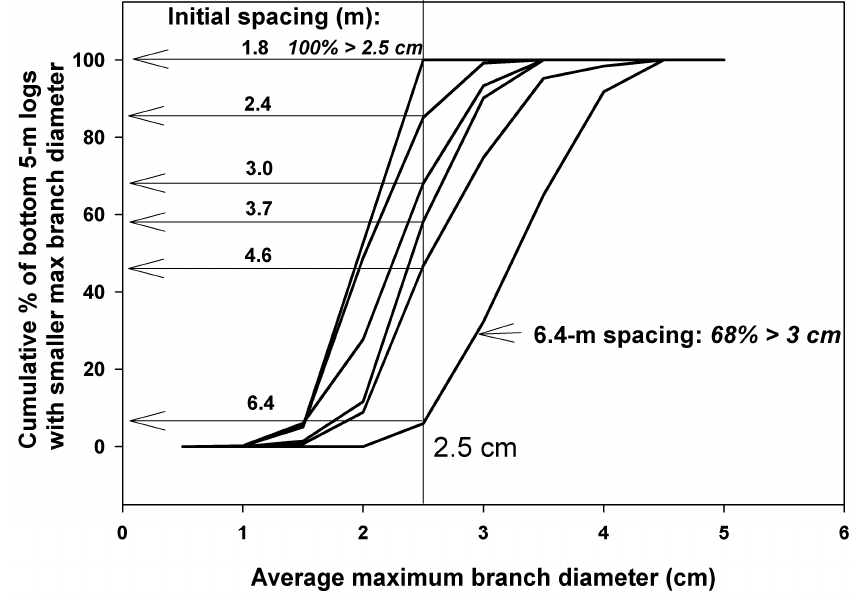
Figure 10. Results from ORGANON growth model simulations showing cumulative frequency of bottom 5-m logs by average maximum whorl branch diameter for six different initial spacings (1.8, 2.4, 3.0, 3.7, 4.6, and 6.4 m) grown out to total age of 49 years; arrows indicate cumulative percentage of logs with average maximum whorl branch diameter less than 2.5 cm; under a 6.4-m spacing, 94% of the bottom 5-m logs have an average maximum whorl branch diameter exceeding 2.5 cm and 68% exceed 3 cm.